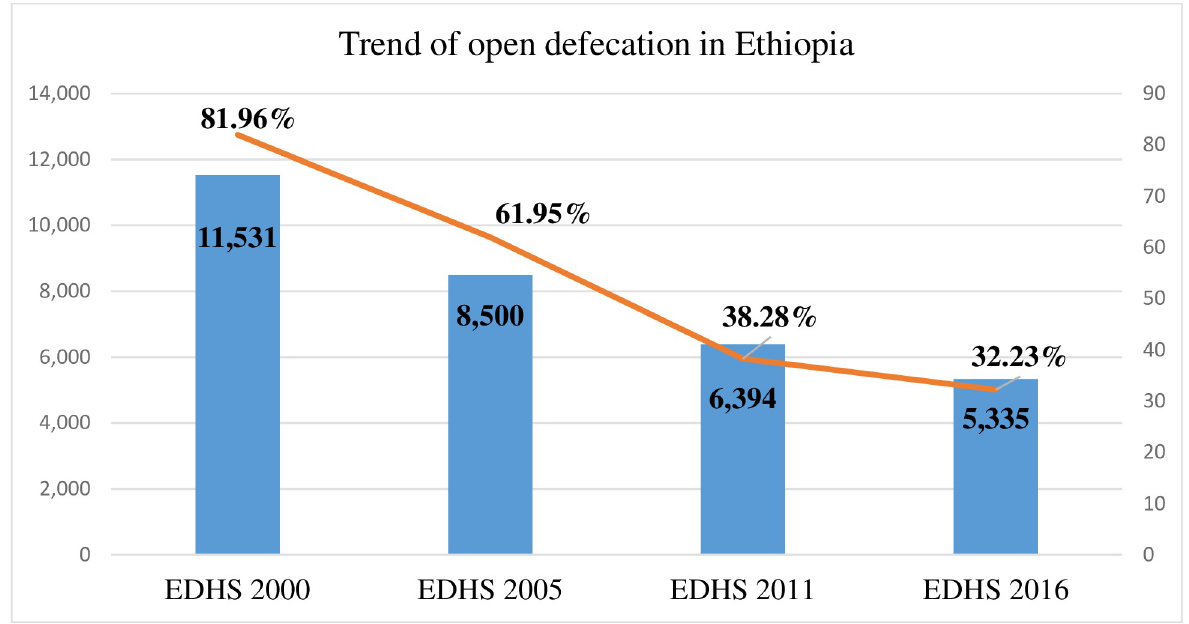
Fig 2. The trend of open defecation practice in Ethiopia.